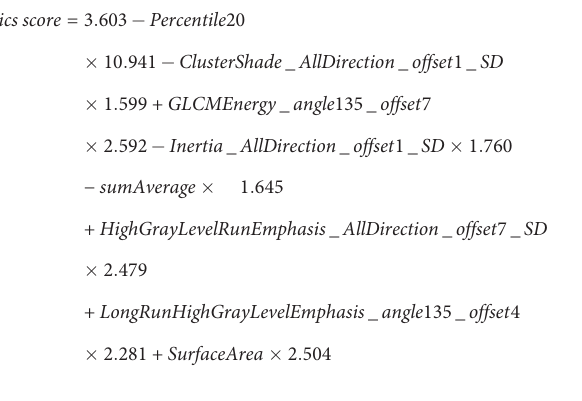
Frontiers in Oncology |